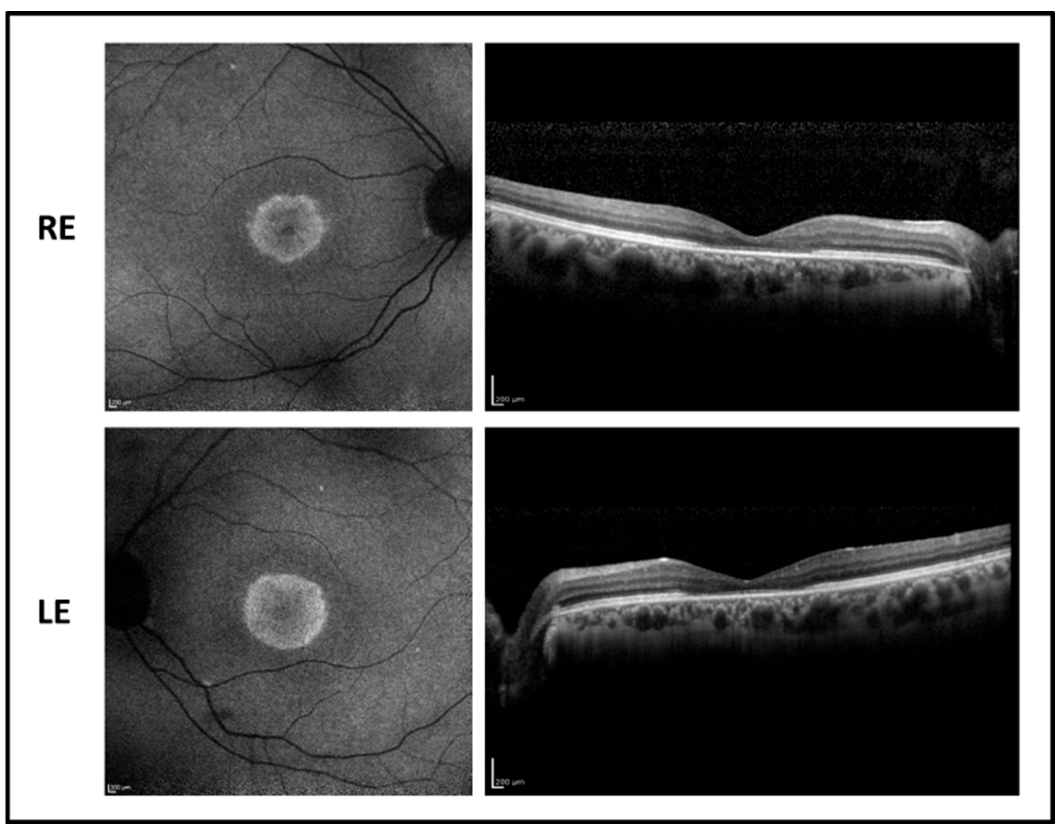
Figure 4. Fundus autofluorescence ( left side ) and OCT ( right side ) images of the right eye (RE) and left eye (LE) of patient 3 showing hyperfluorescent macular area with foveal hypofluorescence and central macular thickness reduction with foveal photoreceptor disruption.